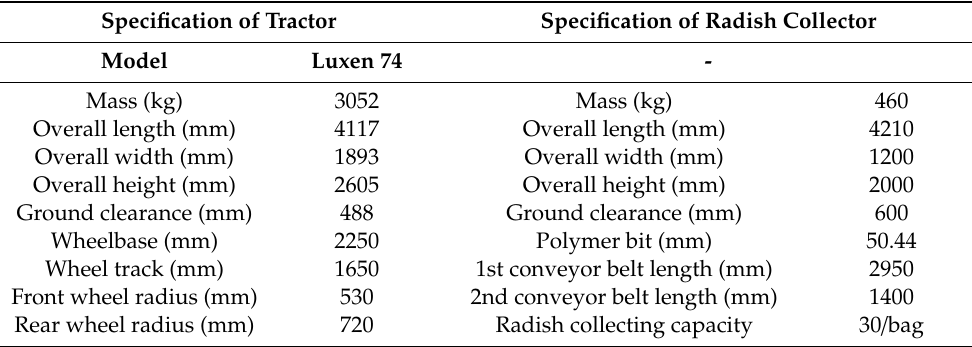
Table 1. Specifications of the tractor and radish